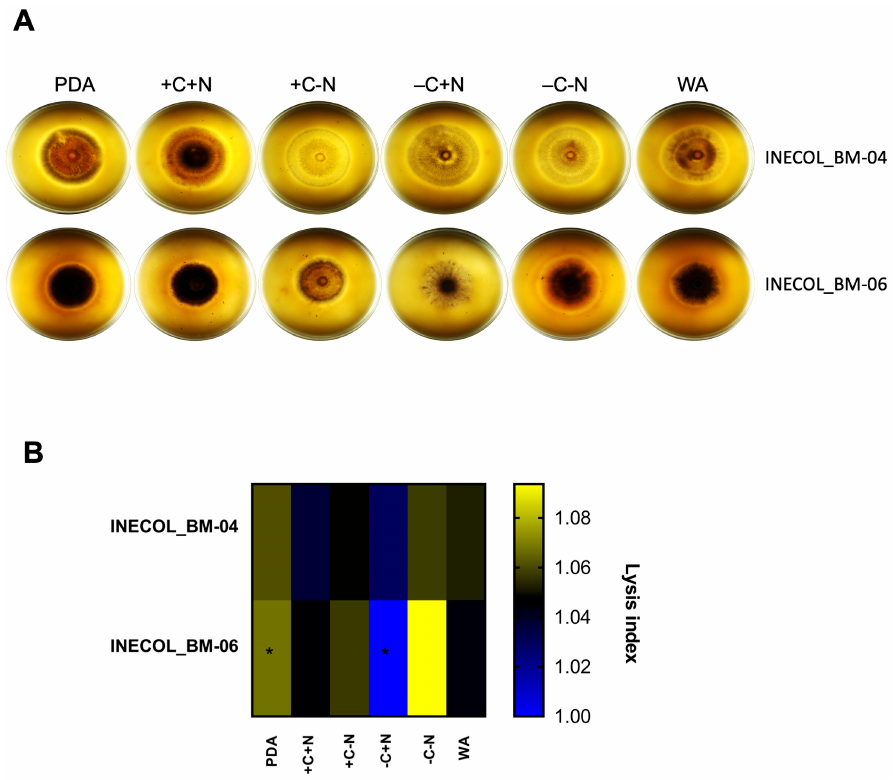
Figure 7. Extracellular Protease activity of Fusarium sp. INECOL_BM-04 and Fusarium sp. INECOL_ BM-06. ( A ) Protease activity of Fusarium spp. associated with X. morigerus indicated by clearing zones in different culture media supplemented with low-fat powder milk 3%. ( B ) Heat Map of